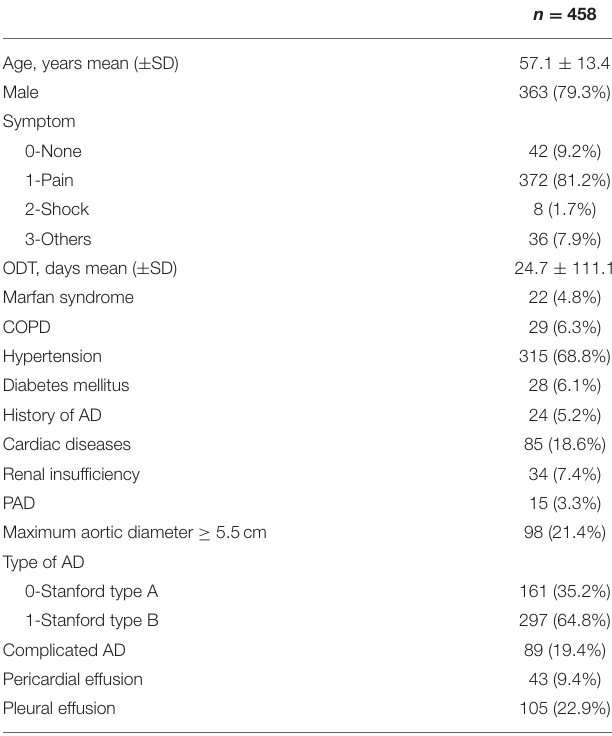
TABLE 1 | Physical and clinical characteristics of the included